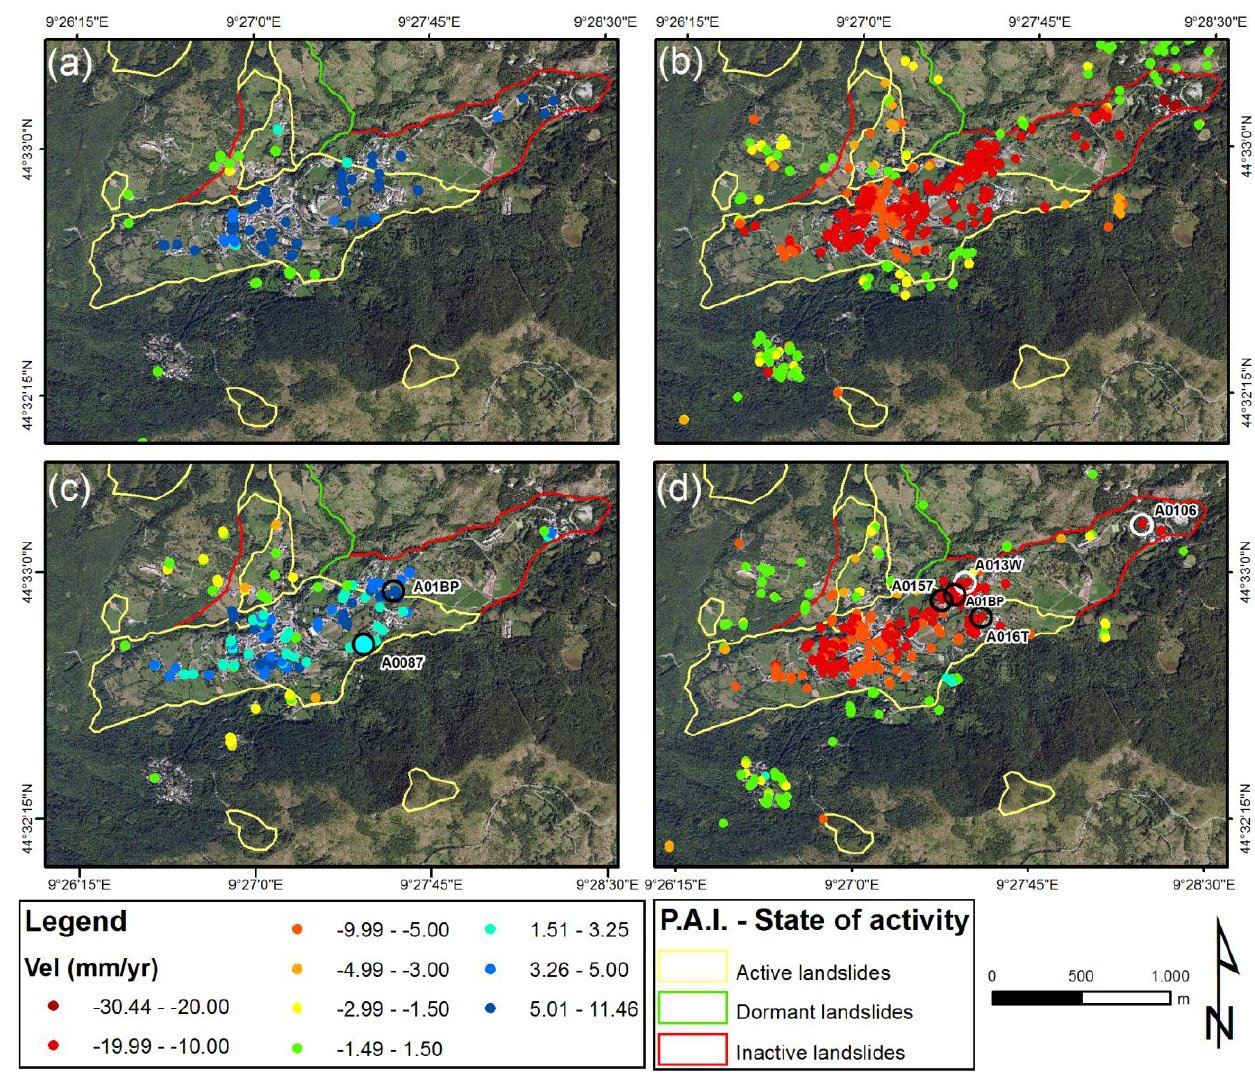
Figure 5. Input multi-interferograms SAR Interferometry (PSI) data available for the